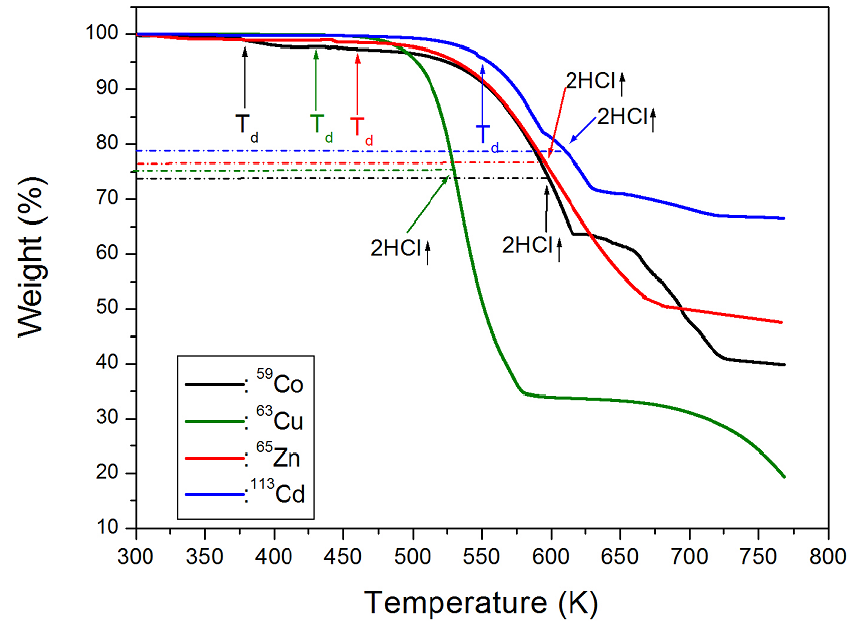
Figure 1. Thermogravimetric analysis (TGA) curve for crystals of (C 2 H 5 NH 3 ) 2 M Cl 4 ( M = Co, Cu, Zn, and Cd).